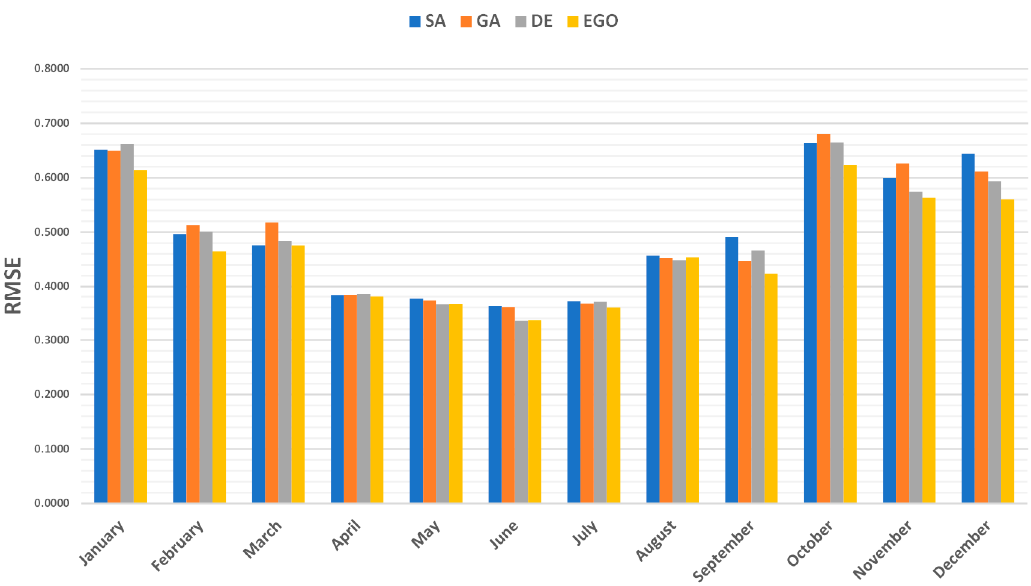
Figure 11. RMSE values for monthly parameter estimation per each technique (own elaboration).